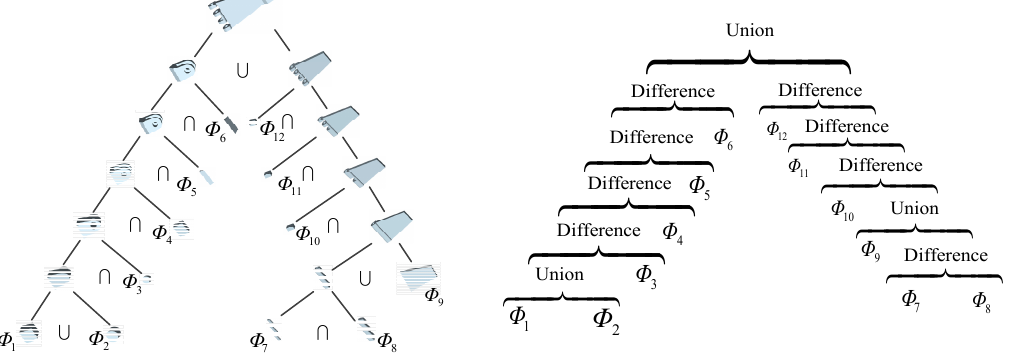
Figure 6. The lifting lug model constructed by Boolean operations.